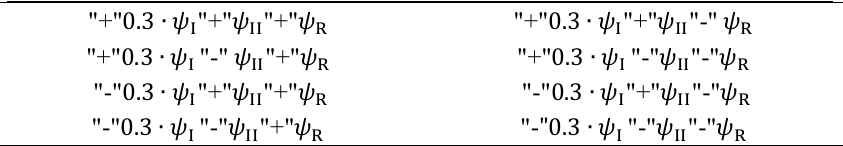
Table 3 . Earthquake Spatial Action of simultaneous floor enforced-displacements, where the displacement along axis 𝐼𝐼 is maximized (index sec has been omitted). sec Eight (8) enforced-displacement combinations of non-linear static analysis.